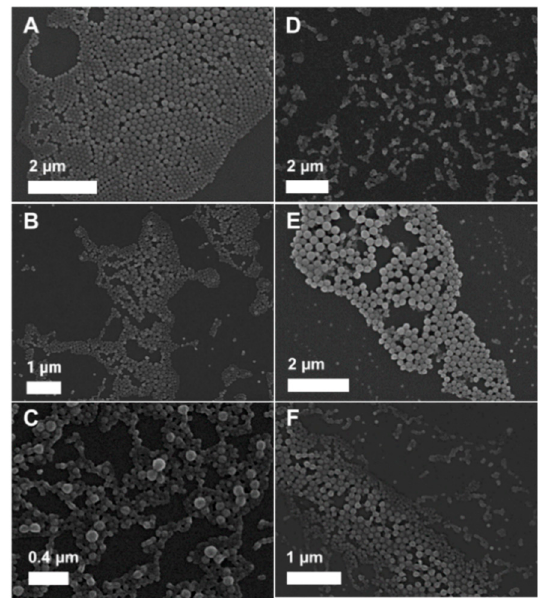
Figure 2. SEM images of PLGA(BRP-187) particles prepared with 5 mg mL − 1 as polymer concentration and 3% BRP-187 ( w / w PLGA) with the different flow rates ( A – F) ; ( A )—P4, ( B )—P5, ( C )—P6, ( D )—P7, ( E )—P8, and ( F )—P9. PLGA, poly(lactic- co -glycolic acid).